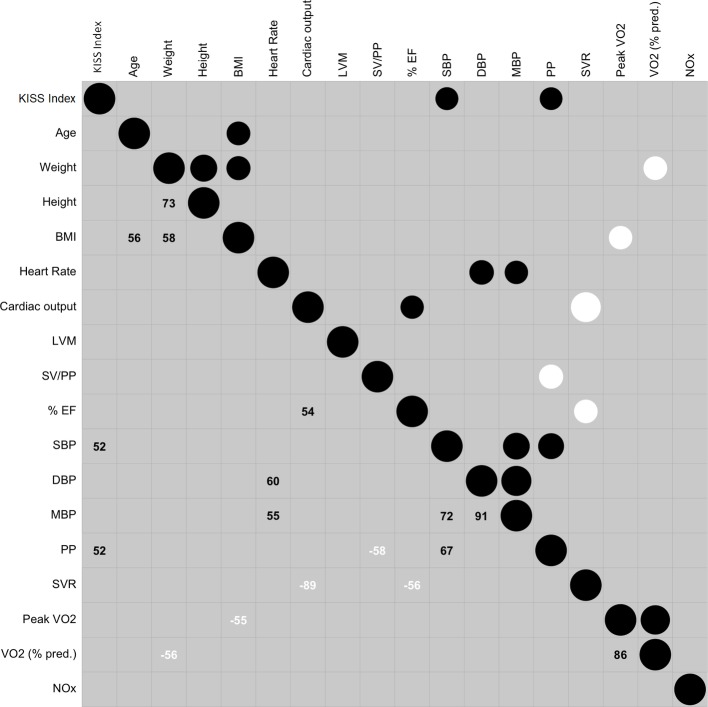
Correlogram reporting the relationship between the variables. The circles in the upper part contain two information: the size reports the absolute value of the relation: the bigger the size is, the higher the strength is. Positive relationship is in black and negative relationship is in white. The larger number in the lower part is r in percentage (r × 100). Abbreviations: KISS, Kisman-Masurel integrated severity score; BMI, body mass index; LVM, left ventricular mass; SV, stroke volume; SV/PP, total arterial compliance; LV FS, left ventricle fraction shortening (%EF); SBP, systolic blood pressure; DBP, diastolic blood pressure; MBP, mean blood pressure; PP, pulse pressure; SVR, systemic vascular resistance; peak VO2, highest value of oxygen uptake; VO2 (% pred.), percentage of predicted peak VO2; NOx, metabolites of nitric oxide.